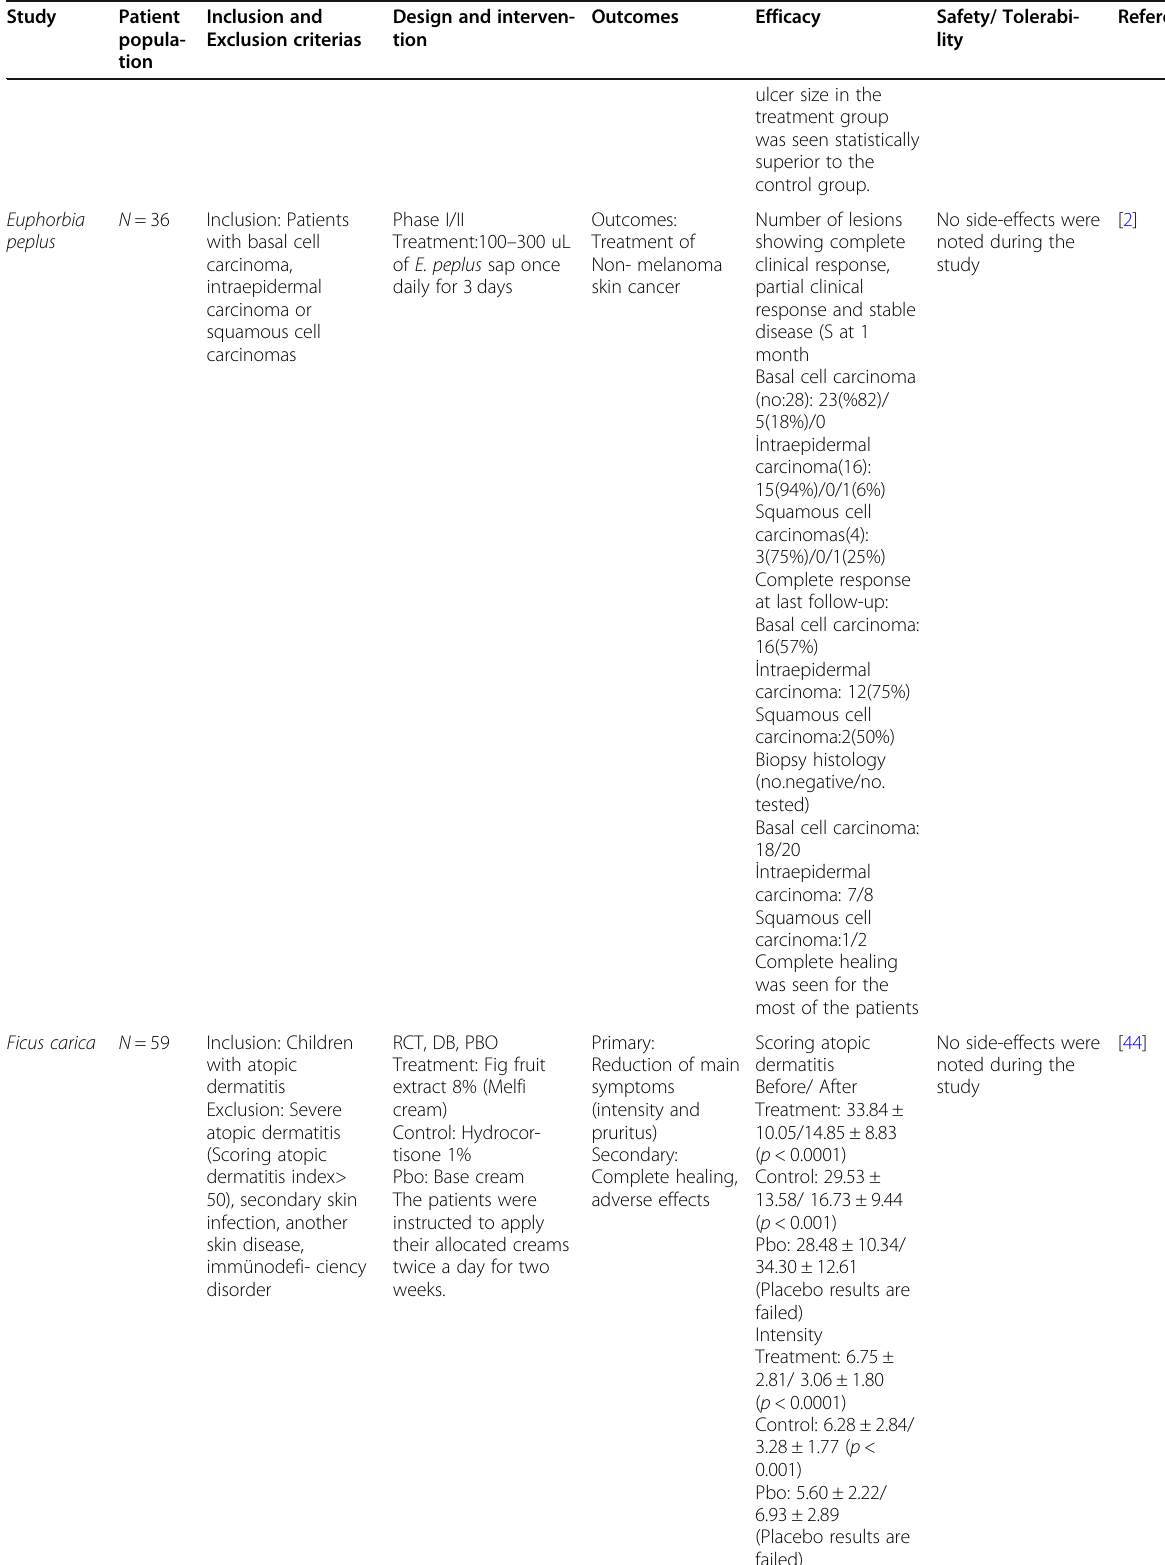
Table 4 Clinical trials of the traditional plants used for skin problems in Turkey (Continued) Study Patient